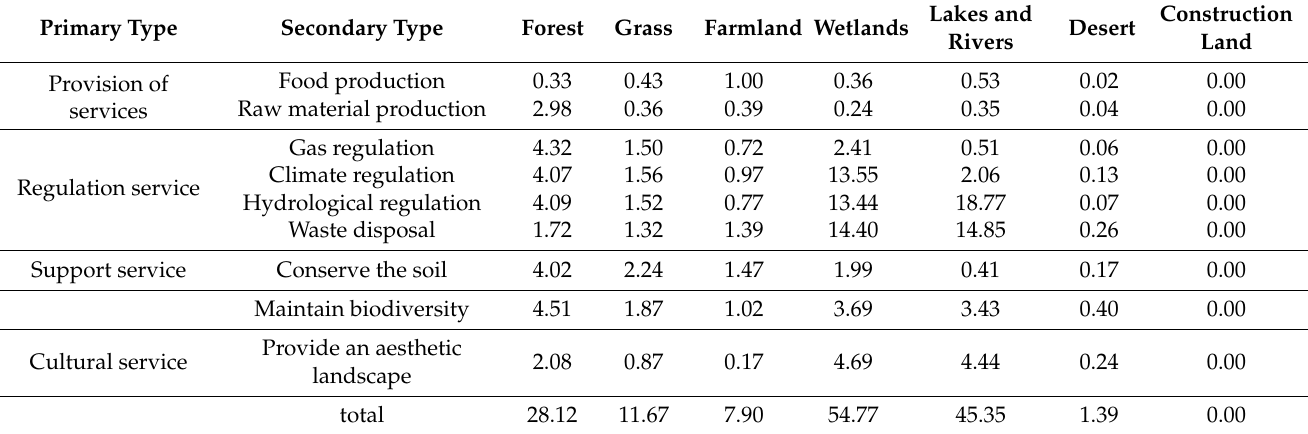
Table 2. Value equivalent of ecosystems services per unit area for China’s ecosystem in 2007.